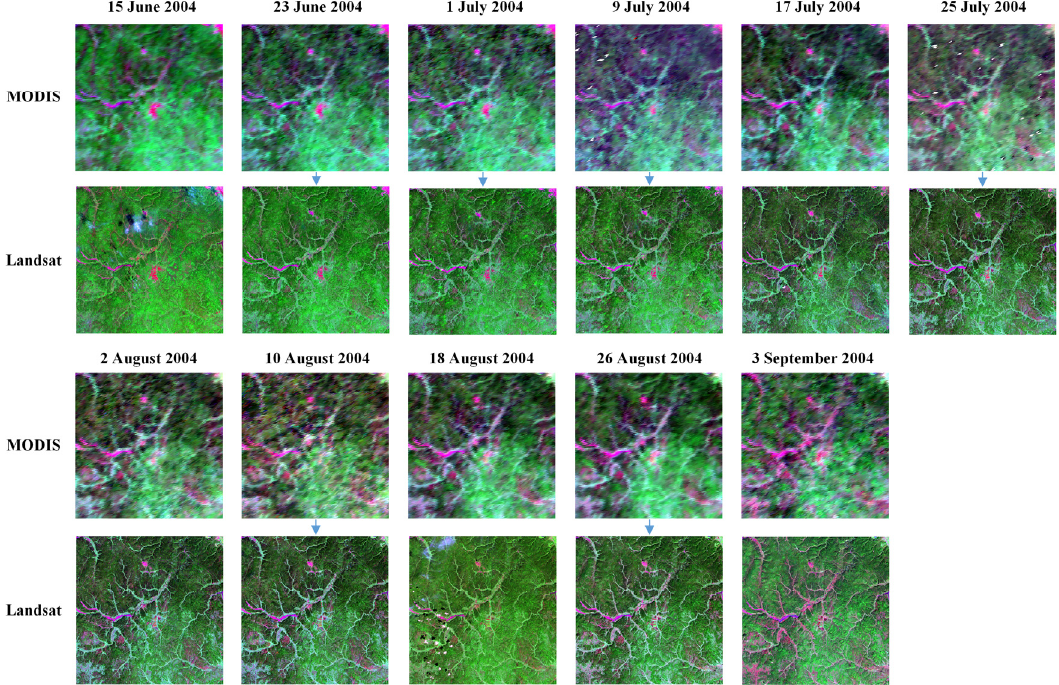
Figure 11. MODIS and Landsat data time series from 15 June to 3 September 2004 in the GKM region. TM images were shown using the 7-4-2 band combination, and MODIS images were shown using the 7-2-4 band combination. The blue arrow between MODIS and Landsat represented that the corresponding Landsat data were reconstructed, rather than the observed reference image.